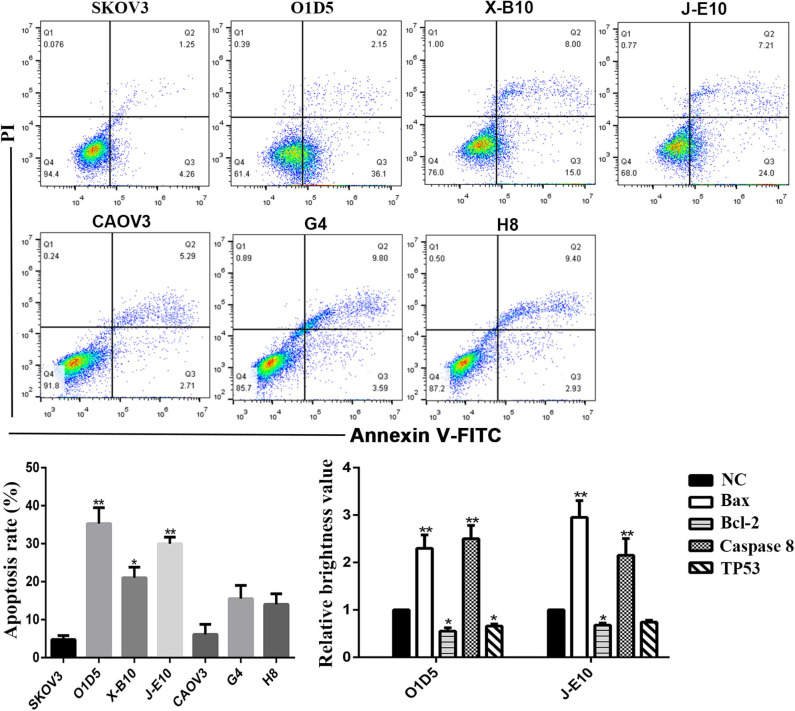
OC-2 KO induced apoptosis activation in SKOV3 and CAOV3 cells. The stained cells were detected by FACS, and the results were analyzed by FlowJo software. Up panel, representative images. Down panel, statistical analysis of apoptosis rate and qRT-PCR analysis of apoptosis markers. *P < 0.05, **P < 0.01.